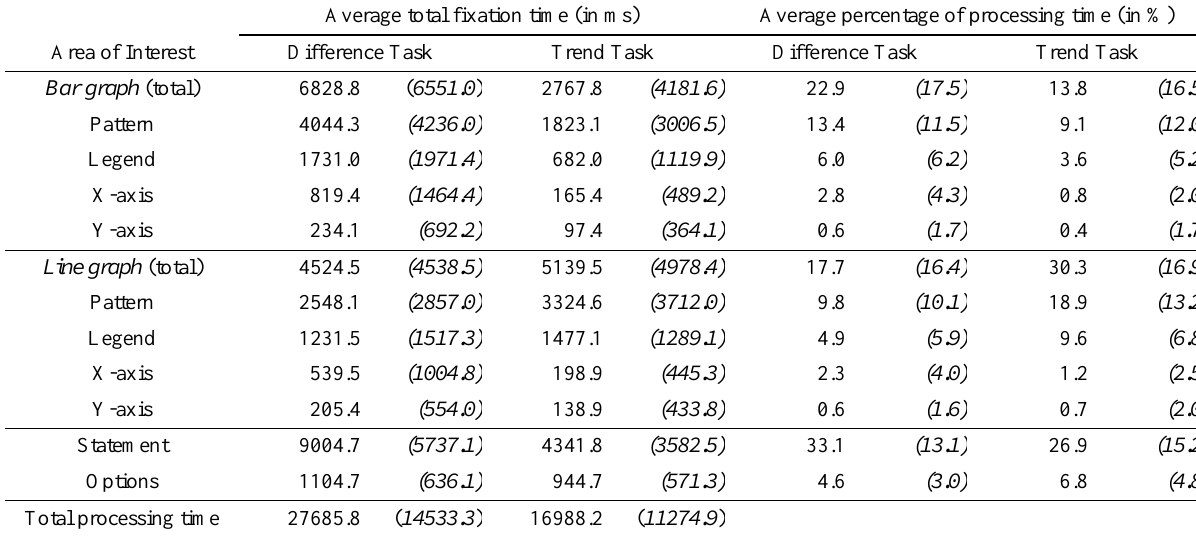
Table 1. Average total fixation times (in ms) and average percentages of processing time (in %) on predefined Areas of Interest for difference and trend task conditions across items (24 trials per condition) and participants (n=30).